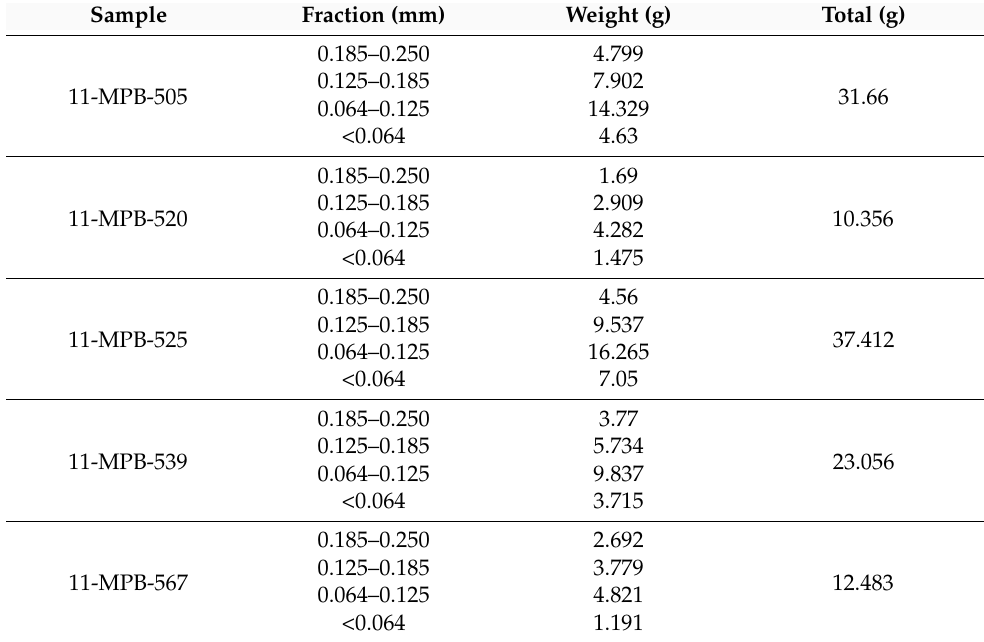
Table 3. Sample processing weights indicating the individual mass of each size fraction following sieving of the <250 µ m